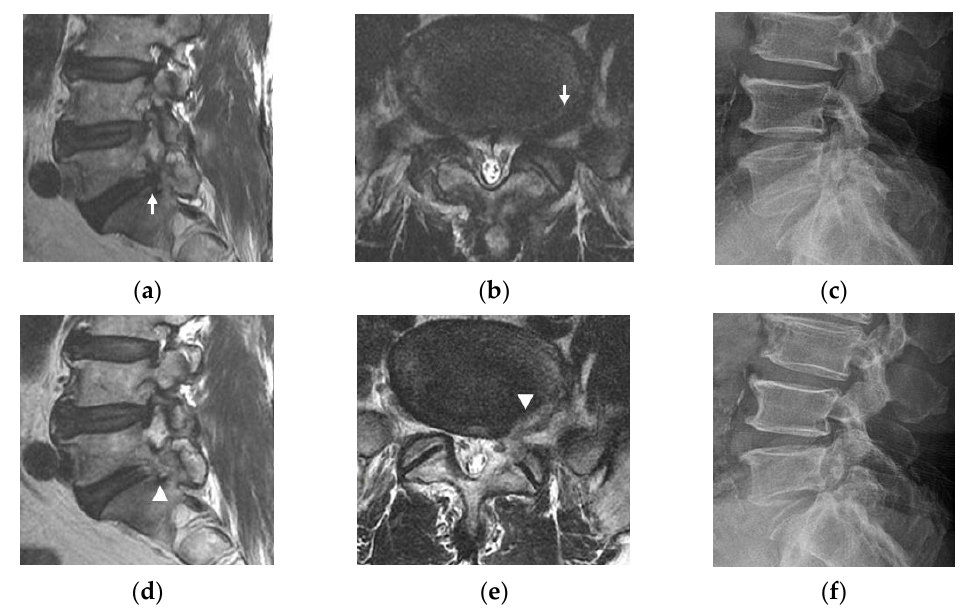
Figure 4. Case example. A 73-year-old female presented with radiating right leg pain and back pain. ( a , b ) Preoperative magnetic resonance imaging (MRI) showing lateral recess, foraminal, and extraforaminal stenosis at L5-S1 on the right (arrows). ( c ) Preoperative lateral radiograph showing previous interbody fusion at L4-L5 and a decreased L5-S1 foraminal window. ( d , e ) Adequate decompression of the lateral recess, foraminal, and extraforaminal lesions was confirmed on postoperative MRI (arrowheads). ( f ) Lateral radiograph at six months after surgery showing no definite spondylolisthesis or narrowing of the L5-S1 foramen. Transient grade 2 postoperative dysesthesia occurred.